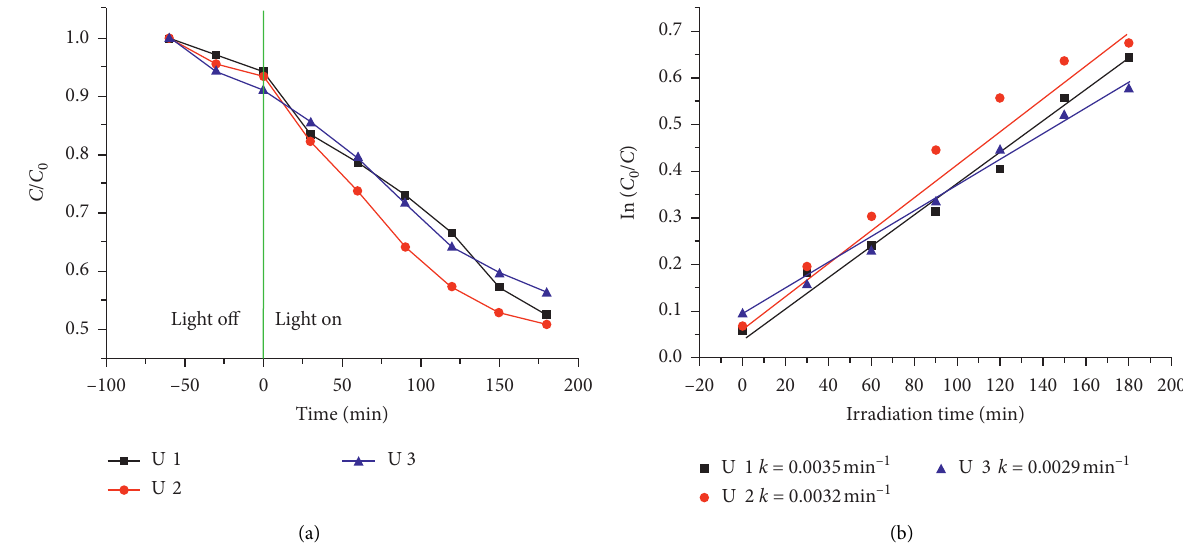
Figure 4: Effect of ultrasonic treatment on the carbamazepine degradation kinetics.